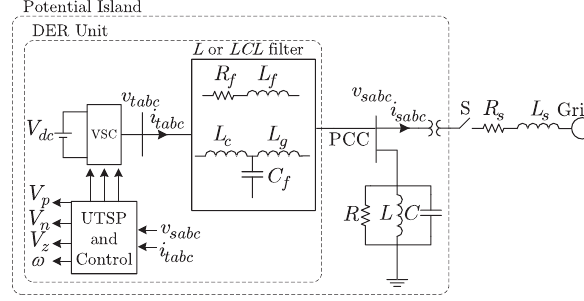
Figure 1. A schematic diagram of the test system.